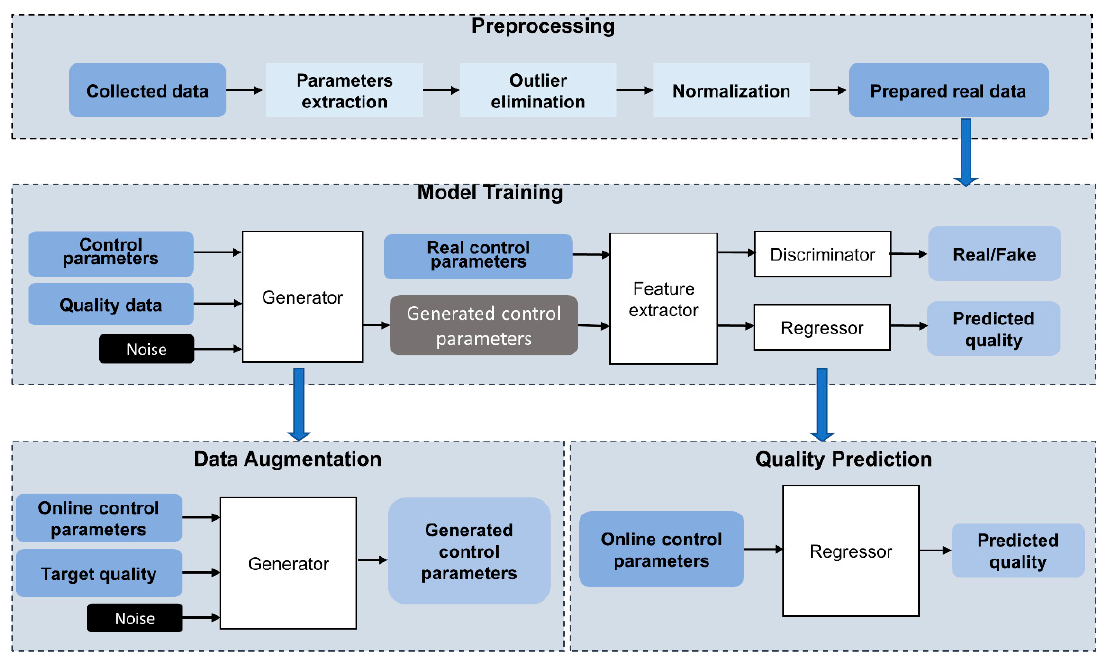
Figure 2. Overview of NCM process modeling using AR-SAGAN.